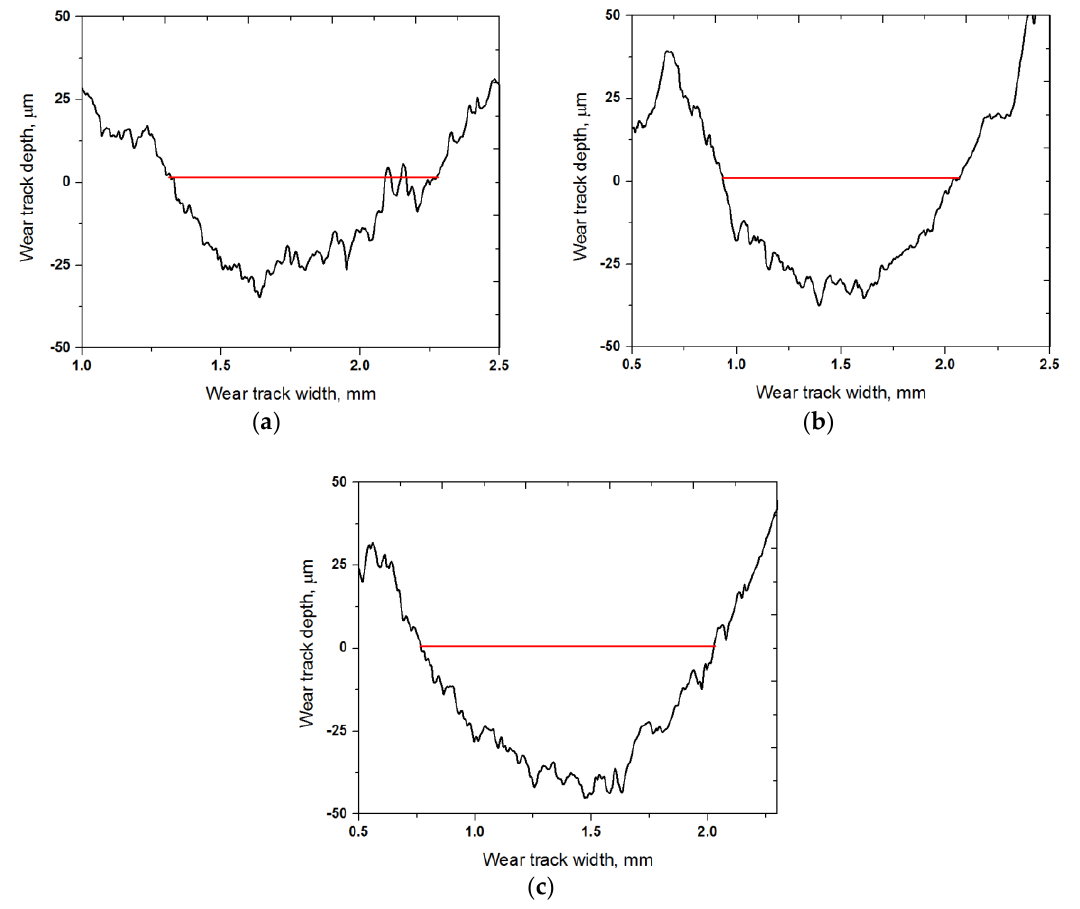
Figure 9. Cross-sectional profiles of wear track formed on the C/C-SiC composite slid against AISI52100 steel at temperatures of 25 °C ( a ); 100 °C ( b ) and 200 °C ( c ). Materials 2017 , 10 , 701